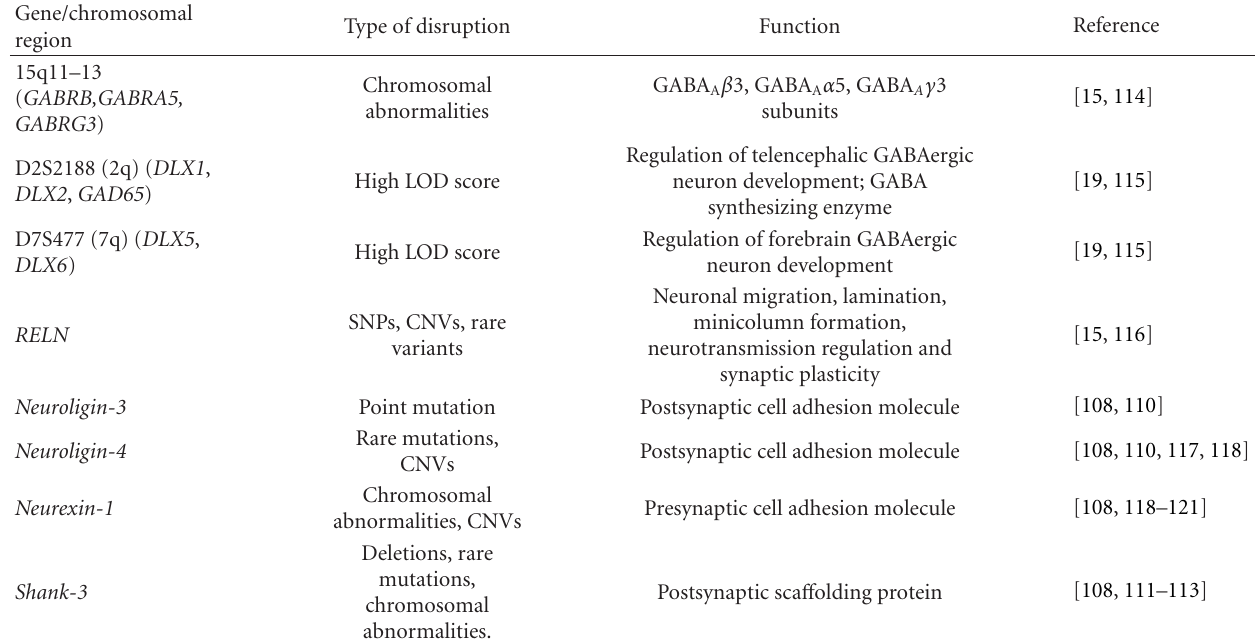
Table 1: Excitatory/inhibitory balance-related genes implicated in